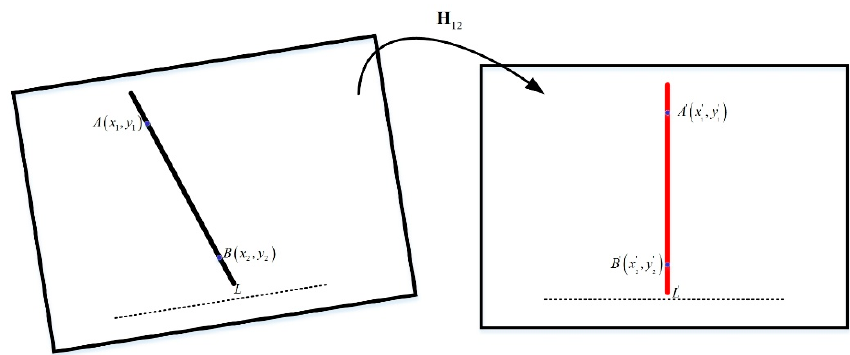
Figure 5. The schematic diagram of one situation.